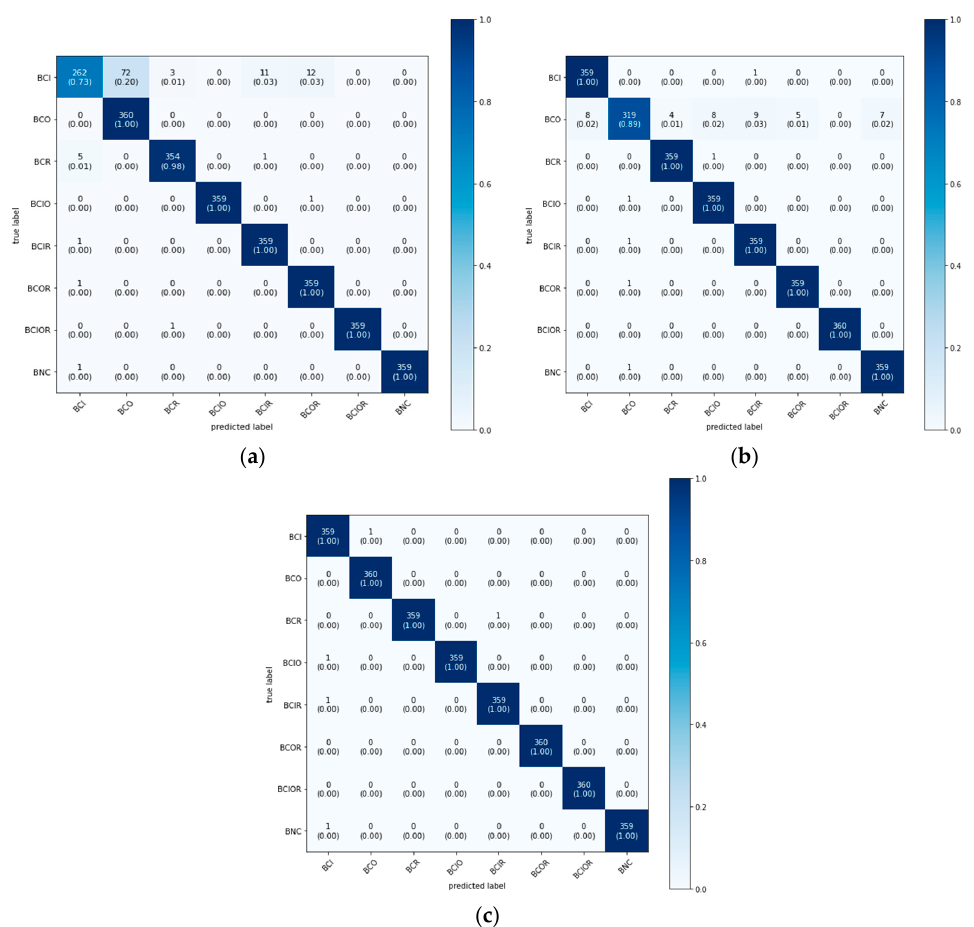
Figure 9. Confusion matrices showing classification results of the proposed method for ( a ) dataset 5, ( b ) dataset 6, and ( c ) dataset 7.